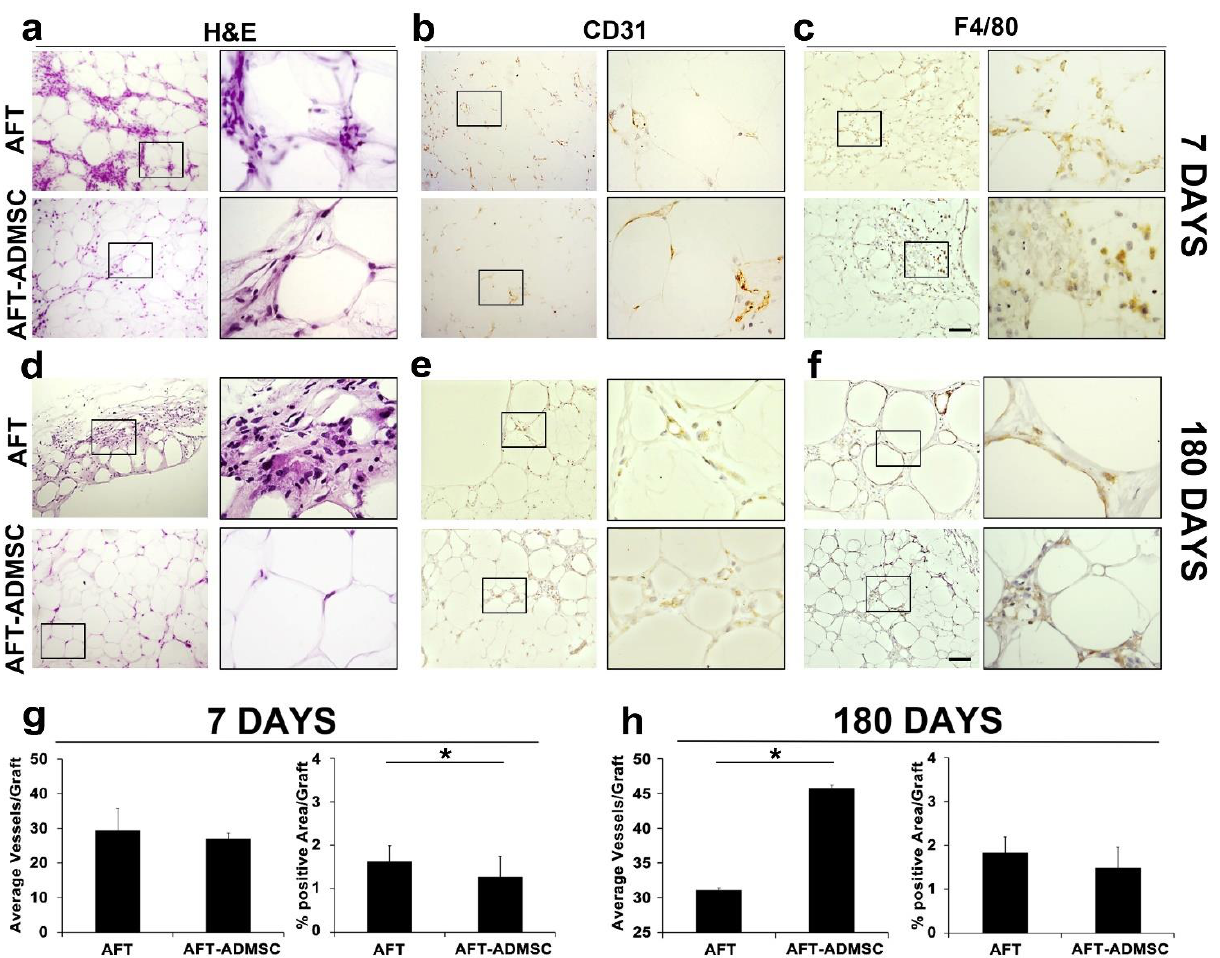
Figure 6. Wild-type ADMSCs exerted proangiogenic and anti-inflammatory effects on the grafts: ( a – c ) histology analysis of the graft at 7 days after transplantation of AFT (upper panel and inset) and AFT-ADMSC (bottom panel and inset) for ( a ) H&E, ( b ) immunohistochemistry for CD31, and ( c ) immunohistochemistry for F4/80; ( d – f ) histology analysis of the graft at 180 days after trans- plantation of AFT (upper panel and inset) and AFT-ADMSC (bottom panel and inset) for ( d ) H&E, ( e ) immunohistochemistry for CD31, and ( f ) immunohistochemistry for F4/80, scale bar = 100 µ m; ( g ) quantitative measurement of CD31-positive vessels for AFT and AFT-ADMSC (left graph) and F4/80-positive area/graft (right graph) at 7 days post-transplantation; ( h ) quantitative measurement of CD31-positive vessels for AFT and AFT-ADMSC (left graph) and F4/80-positive area/graft (right graph) at 180 days post-transplantation. Quantification was performed using Image J software; * p < 0.05, n =